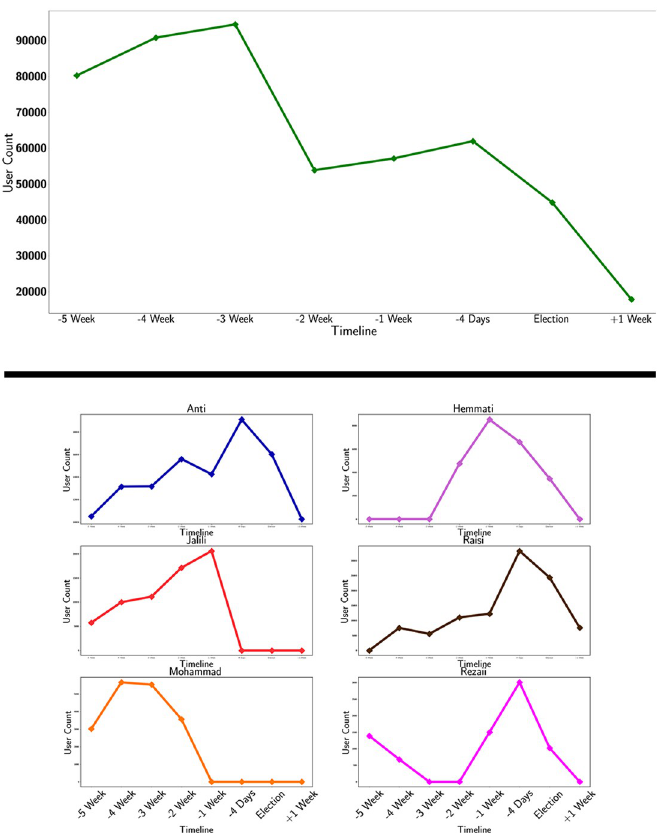
Fig 3. Top: The amount of users that participated in the retweet network about the election by tweeting a trending hashtag. Bottom: The amount of participating users separated by communities.